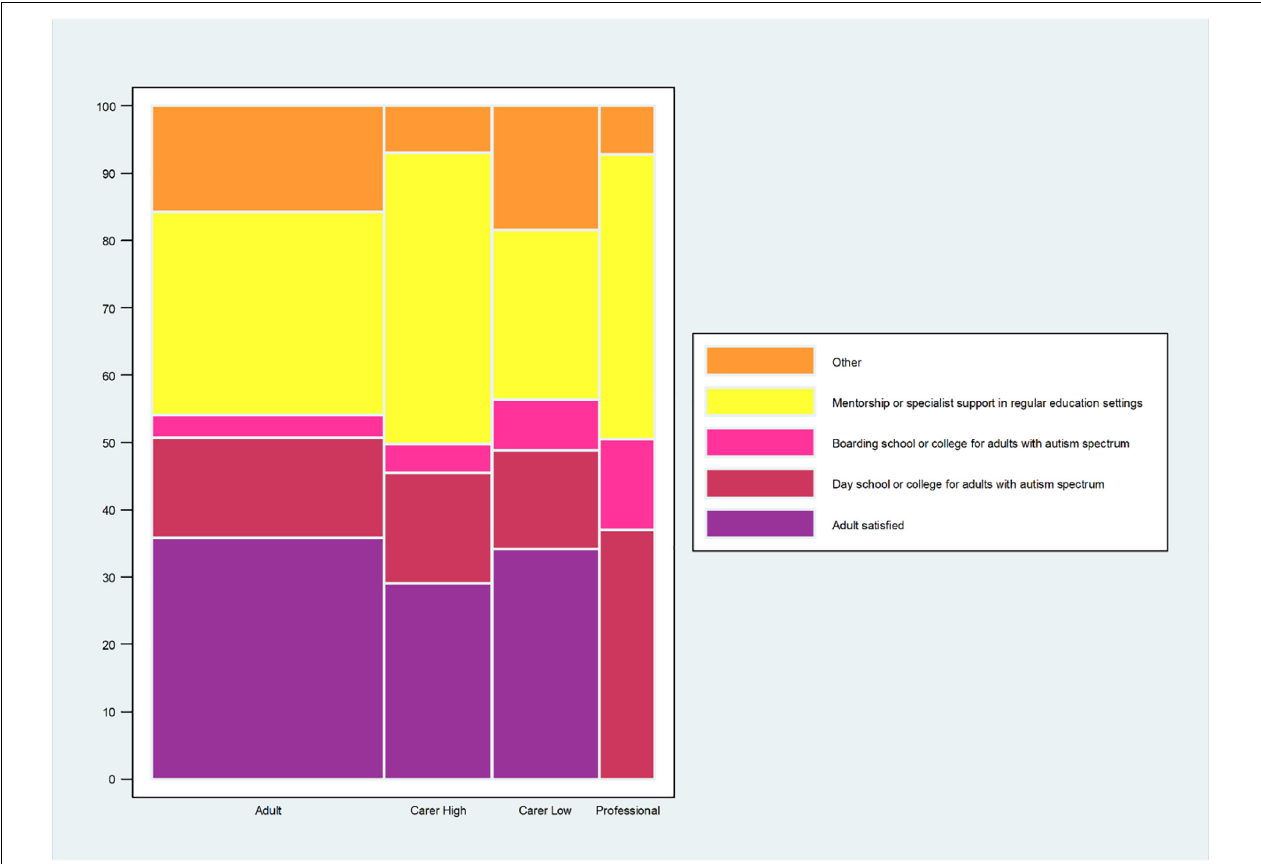
FIGURE 4 | Preferred adult education service. The question for the autistic adults was: “ If you could choose an education service that fits your needs best now, what would you choose? (Please, tick 1 box).” The question for the carers of autistic adults was: “If you could choose an education service that fits the adult’s needs best now, what would you choose? (Please, tick 1 box).” The carers’ data are stratified by high and low level of independence of the autistic adult. The question for the professional was: “Which 2 types of education services do you think are most needed for autistic adults in the (geographical) area where you work now? (Please, tick 2 boxes).” Professionals who selected “ I prefer not to make a choice ” are not included in the calculation of% for each of the other answer choices. The %s for the other answer choices are based on the professionals who made a choice, n = 111 (124–13 = 111). *This% is calculated on the total sample of the professionals’ responders ( n = 124). Data are for all adults and carers of